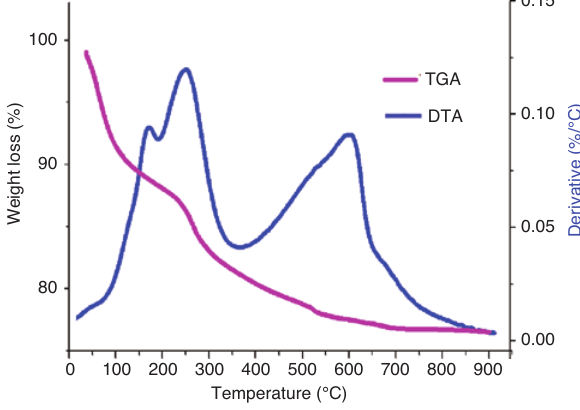
Figure 3: TGA/DTA thermogram of the synthesized